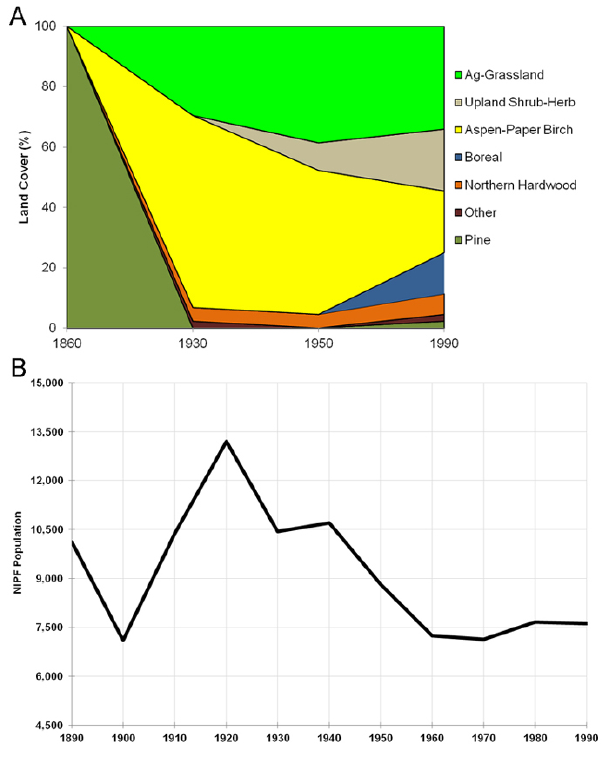
Fig. 8. Coupled human and natural systems elements of